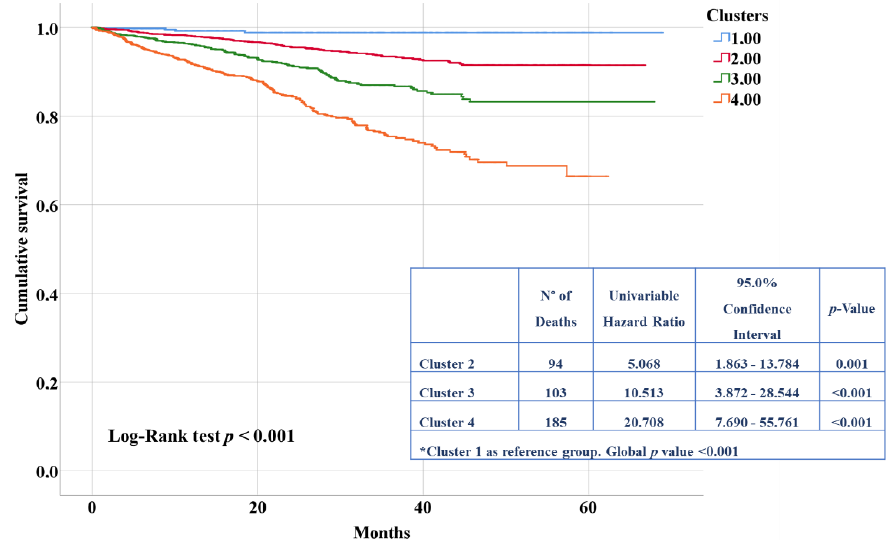
Figure 2. Kaplan–Meier curves for risk of mortality according to different clusters.